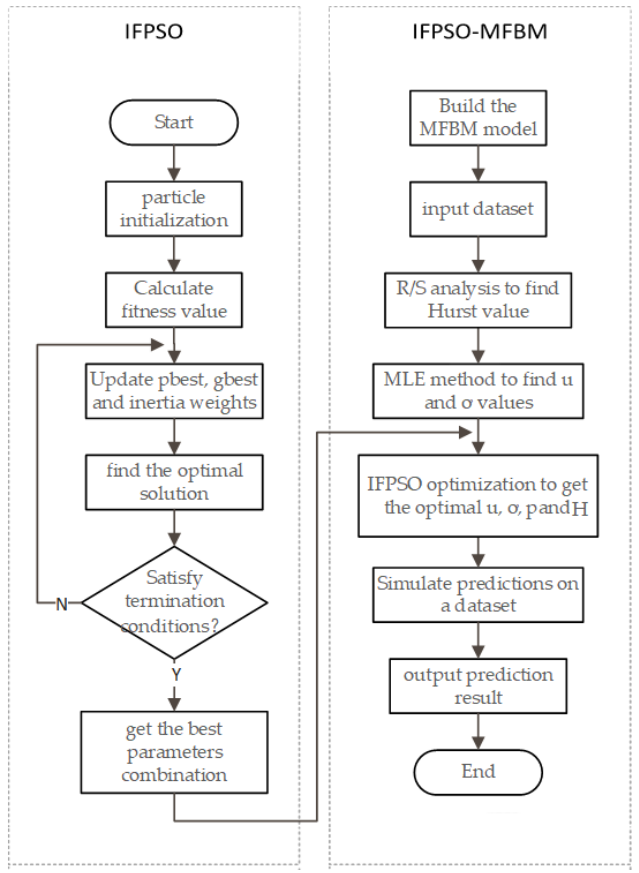
Figure 1. IFPSO-MFBM prediction model flow chart.